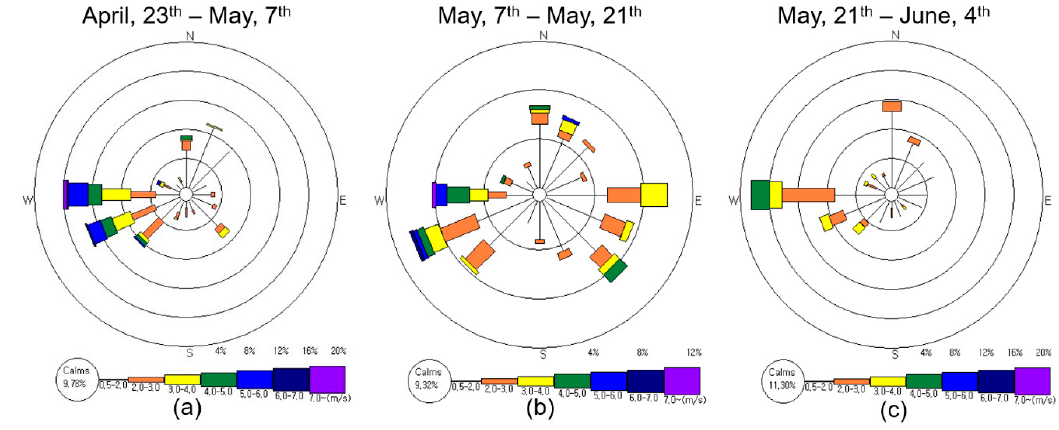
Figure 3. Wind rose diagrams of the study site during April 23–June 4. Calm wind refers to when the wind speed is lower than 0.5 m·s − 1 . ( a ) After tillage (April 23–May 7); ( b ) After chemical fertilizer application and irrigation (May 7–May 21); ( c ) After transplanting rice seedlings (May 21–June 4).